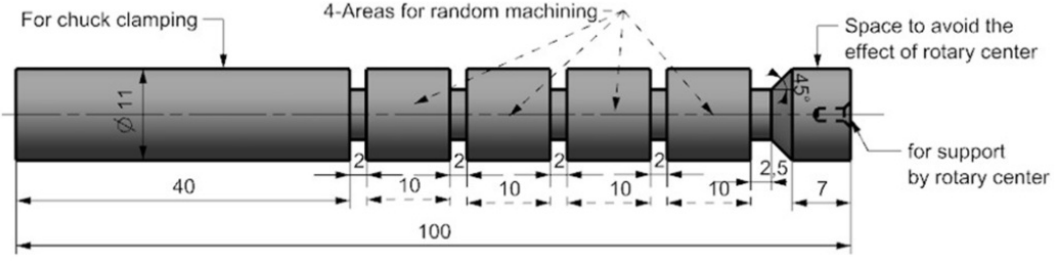
Figure 2. Test specimen drawing (unit: mm). Table 2. A selection of surface roughness values listed under different cutting conditions.